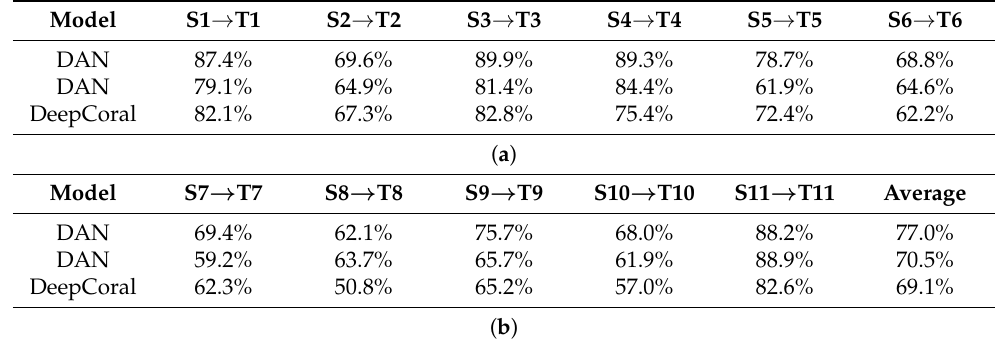
Figure 8. Variation in prediction accuracy with the number of training sessions in four groups. ( a ) Group 1; ( b ) Group 2; ( c ) Group 3; ( d ) Group 4. Table 2. Prediction accuracy of different sample combinations under the three models. ( a ) First six groups’ prediction accuracy; ( b ) The prediction accuracy of the last five groups; and the average accuracy of all